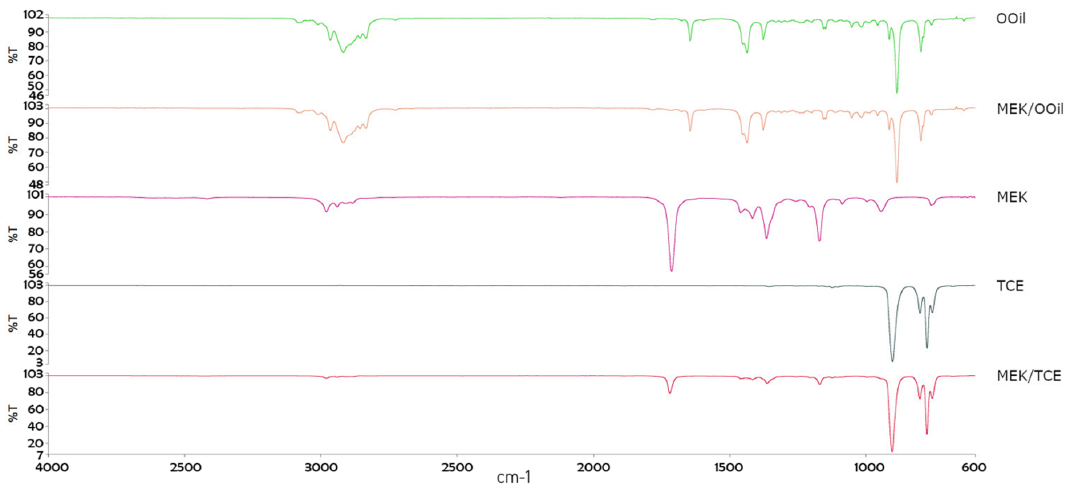
Figure 1. Frontier Fourier transform infrared (FTIR) spectroscopic plots of the isolated solvents and binary mixtures—OOil, orange oil; MEK / OOil; MEK, methyl ethyl ketone; TCE, tetrachloroethylene; MEK / TCE.